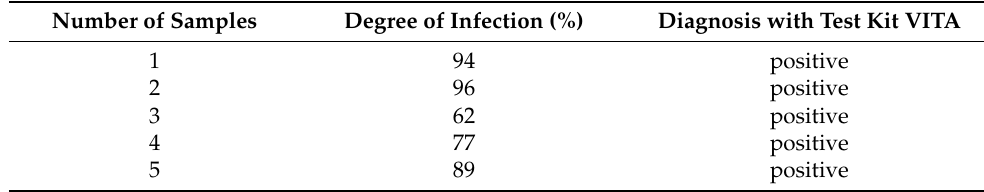
Table 1. Infection level (%) of bee colonies diagnosed with AFB. Number of Samples Degree of Infection (%) Diagnosis with Test Kit VITA